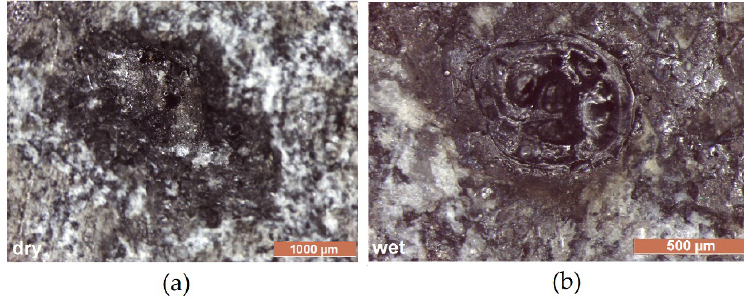
Figure 7. Optical microscopy images of fulgurite on dry testing sample A0.